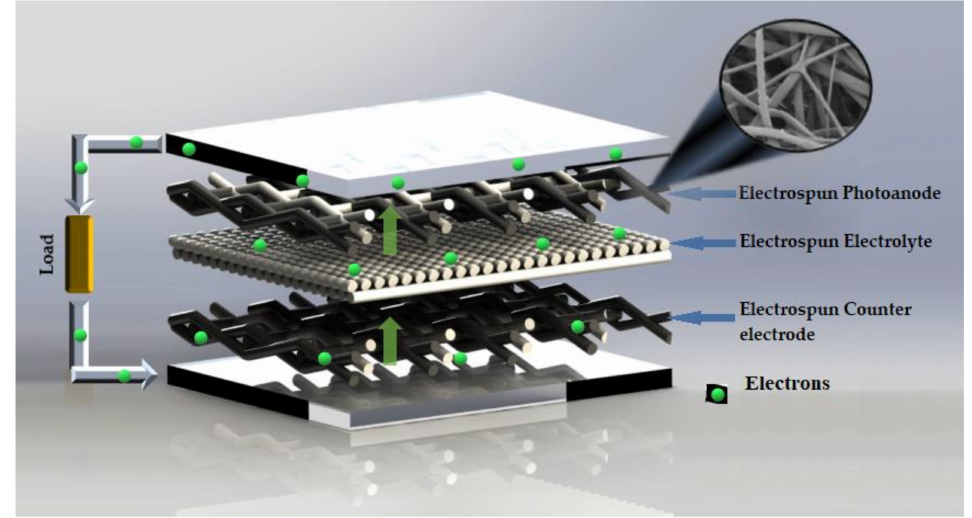
Figure 6. Position of electrospun nanofibers in DSSC (photoanode, electrolyte and counter electrode) (based on